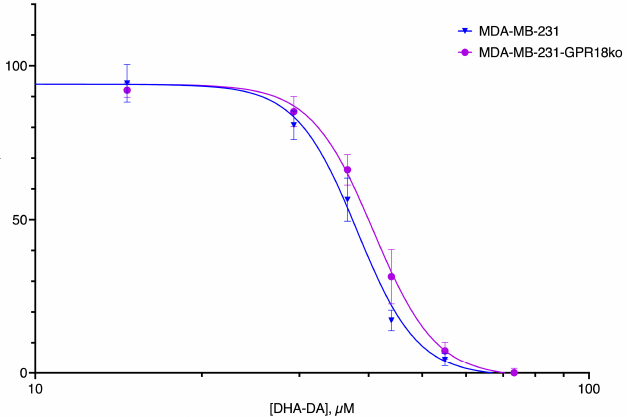
Figure 11. Cytotoxicity of DHA-DA for the original line MDA-MB-231 and the variant with knockout GPR18, incubation time 24 h, MTT test data. Pooled data from 7 experiments; mean±standard error. Table 3. The effect of GPR18 receptor knockout on DHA ‐ DA cytotoxicity. Incubation 24 hours; MTT test. Cell Line Variant MDA ‐ MB ‐ 231